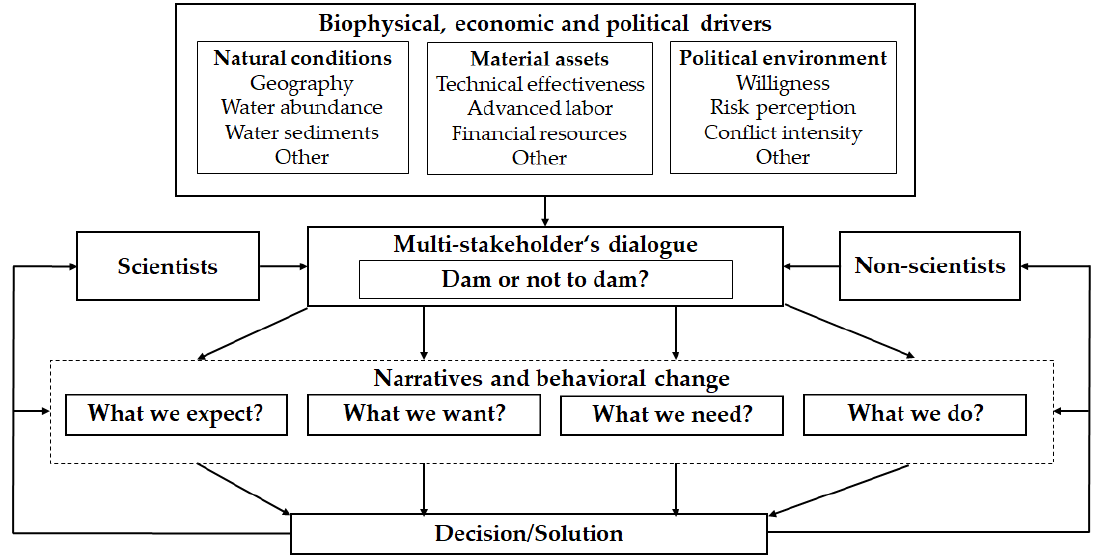
Figure 3. Conceptual scheme highlighting the systemic impact of the hydropower development.